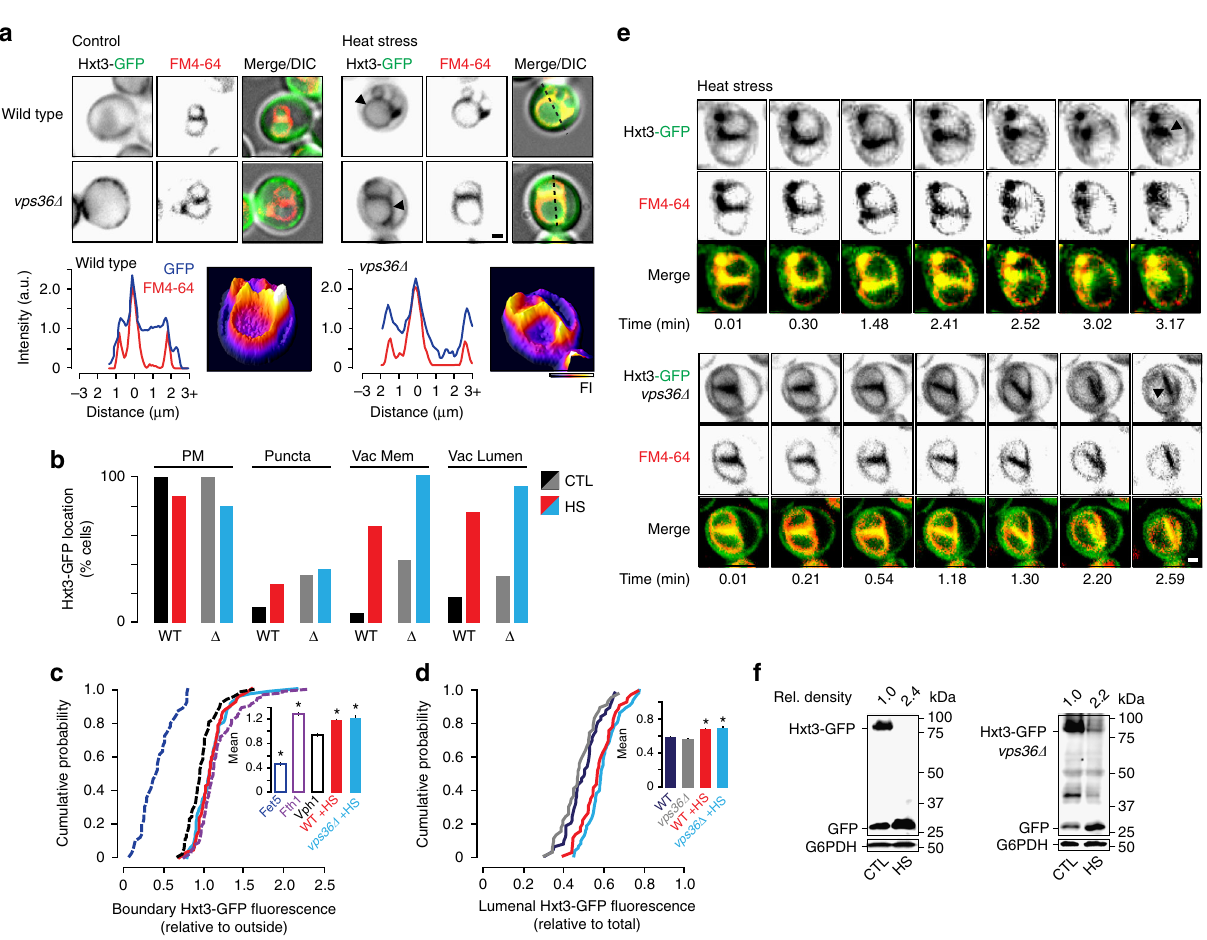
Fig. 3 Quality control of Hxt3-GFP is mediated by the ILF pathway. a Fluorescence and DIC micrographs of live wild type or vps36 Δ cells expressing GFP- tagged Hxt3 before (control) or after heat stress (37 °C for 15 min). Vacuole membranes were stained with FM4 – 64. Arrowheads indicate GFP on the vacuole membrane. 3-dimensional GFP fl uorescence intensity (FI) plots and line plots of Hxt3-GFP or FM4 – 64 fl uorescence intensity for lines shown in a , to indicate vacuole membrane localization after heat stress. b Micrographic data shown in a was used to calculate the proportion of wild type or vps36 Δ cells that show Hxt3-GFP fl uorescence on the plasma membrane (PM), intracellular puncta, vacuole membrane (Vac Mem) or vacuole lumen (Vac Lumen) before or after treatment with heat stress. Under control (CTL) conditions, n = 218 WT cells or 243 vps36 Δ cells under control conditions (CTL); n = 163 WT cells or 196 vps36 Δ cells after heat stress. c , d Micrographic data shown in a was used to generate cumulative probability plots of Hxt3-GFP fl uorescence measured within the boundary membrane ( c ) or lumen ( d ) of vacuoles within live wild type or vps36 Δ cells before or after heat stress (HS). GFP-tagged Fet5 (excluded), Vph1 (ubiquitous) and Fth1 (enriched) are shown for reference (see Fig. 2D). Averages ± S.E.M. are shown in insets. * P < 0.05, as compared to Vph1 by t -test. n = 3 experiments whereby a total of 81 WT or 102 vps36 Δ cells were analyzed under control conditions, and 75 WT or 88 vps36 Δ cells were analyzed after heat stress. e Images from time-lapse videos showing homotypic vacuole fusion events within live wild type or vps36 Δ cell expressing Hxt3-GFP treated with heat stress. Vacuole membranes were stained with FM4 – 64. Arrowheads indicate newly formed ILFs. See Supplementary Movies 2 and 4. Example shown is a representation of n = 4 experiments. f Western blot analysis of whole-cell lysates prepared from wild- type or vps36 Δ cells expressing Hxt3-GFP after heat stress (HS) stained with anti-GFP antibody. Estimated molecular weights and cleaved GFP band densities relative to CTL normalized to load controls (G6PDH) are shown. Blots shown are representatives of n = 3 experiments. Scale bars, 1 µ